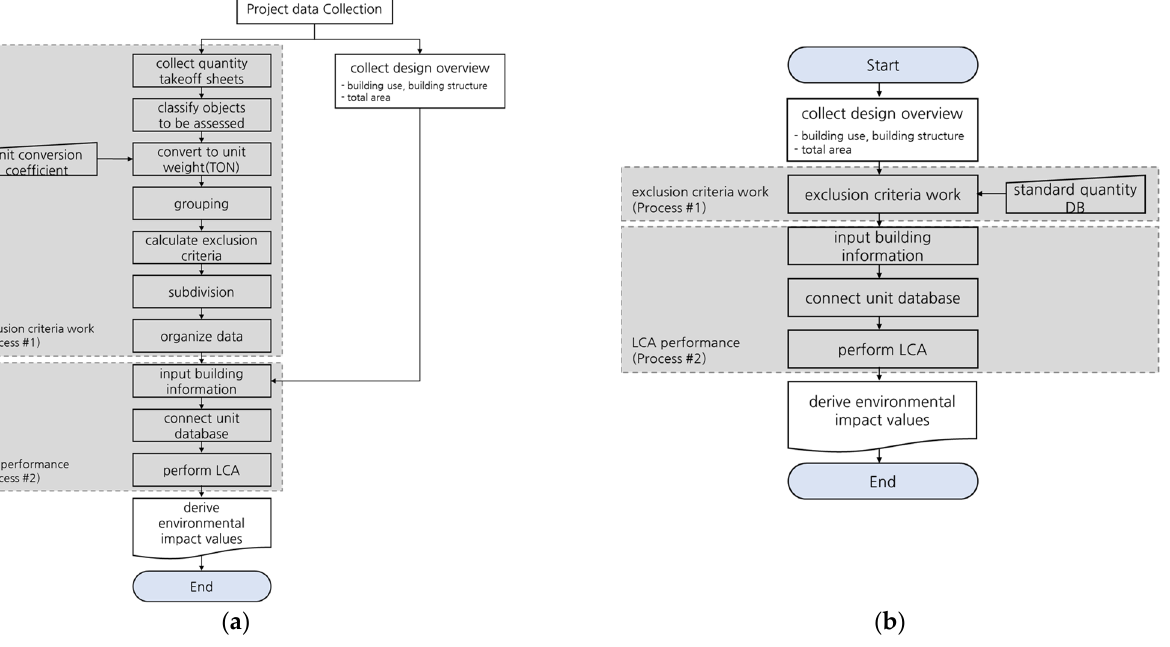
Figure 4. Green Standard for Energy and Environmental Design building life cycle assessment (LCA) (( a ) conventional) and building LCA based on the standard quantity database (( b ) this study).